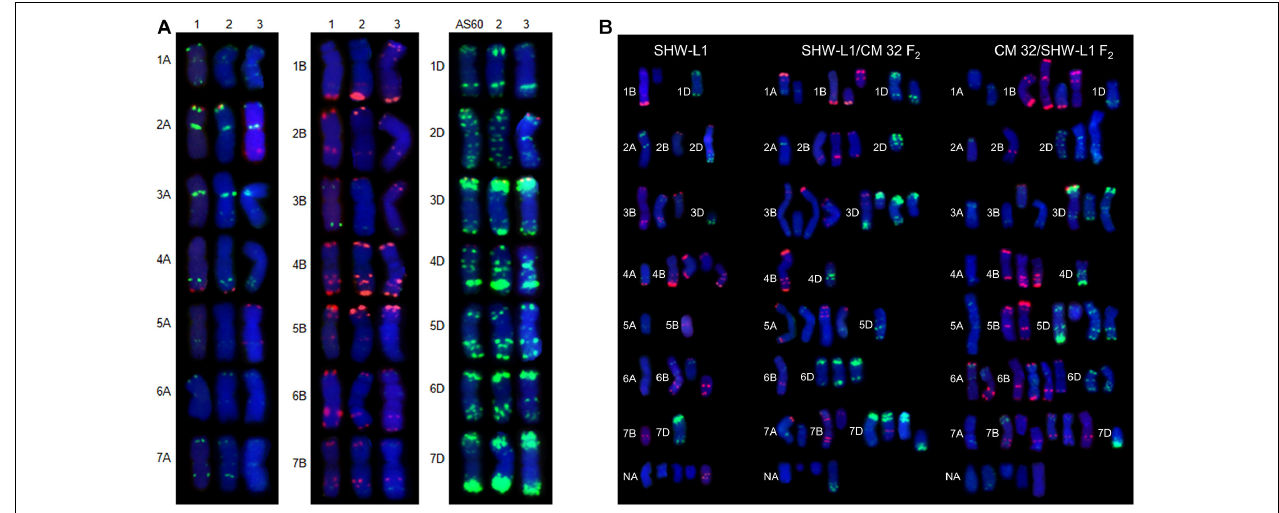
FIGURE 1 | FISH karyotypes. (A) FISH karyotypes of SHW-L1 with its parents and Chuanmai 32. 1, tetraploid wheat AS2255; 2, SHW-L1; 3, Chuanmai 32. (B) Chromosomal structural variations detected in SHW-L1 and F 2 hybrids derived from reciprocal crosses between SHW-L1 and Chuanmai 32. Green FISH signals are from probe oligo-pTa-535; red signals are from probe